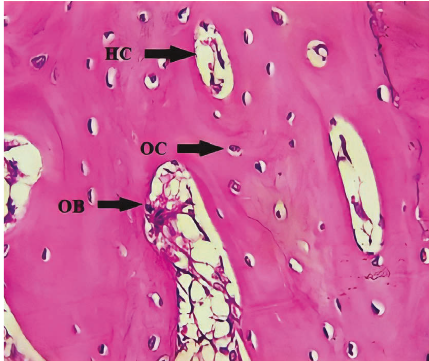
Figure 5: A view of the defect site in the GS group shows bone trabeculae surrounding the Haversian canals (HC), which are lined by OB and surrounded by OC, after 4-weeks. H&E x40.